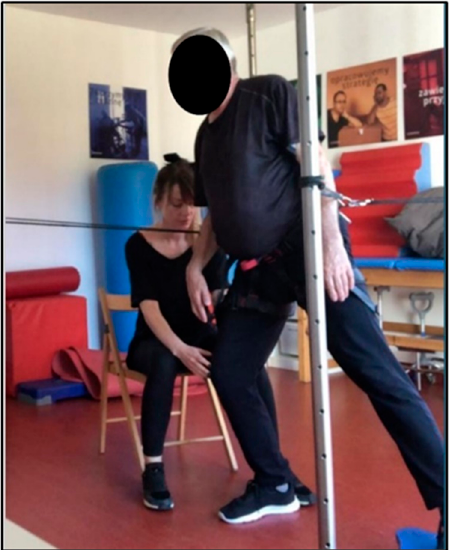
Figure 5. Patient I during therapy with usage of the SPIDER system (own source).